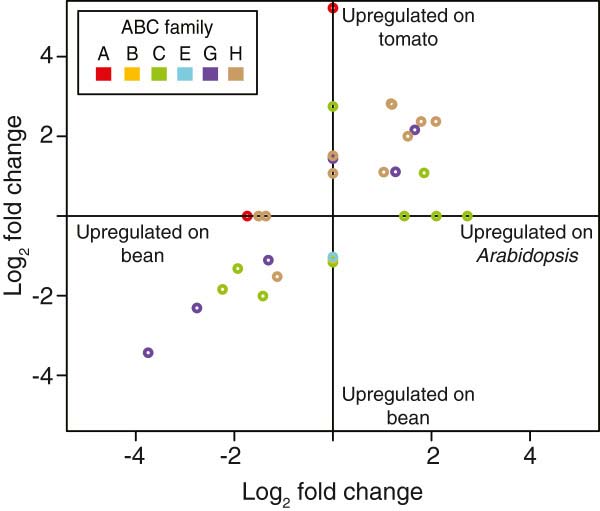
Full length differentially expressed (fold change ≥ 2, FDR adjusted p-value <0.05) ABC genes in mites after host plant change from bean to either Arabidopsis or tomato. Subfamilies are color-coded as follows: ABCA, red; ABCB, yellow; ABCC, green; ABCE, blue; ABCG, purple; and ABCH, brown. Genes found to be significant in only one of the pairwise comparisons have had their fold change values assigned to zero for the non-significant comparison. Fold change values of differentially expressed ABC genes can be found in Additional file 13.